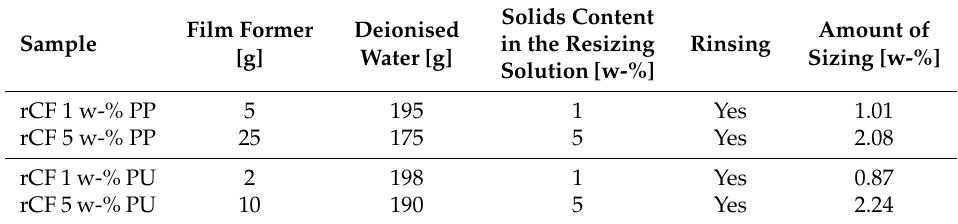
Table 3. The rCF sizing solution formulations for 1 and 5 w-% solid content solutions and the related process steps together with the amount of sizing obtained from thermogravimetric analysis